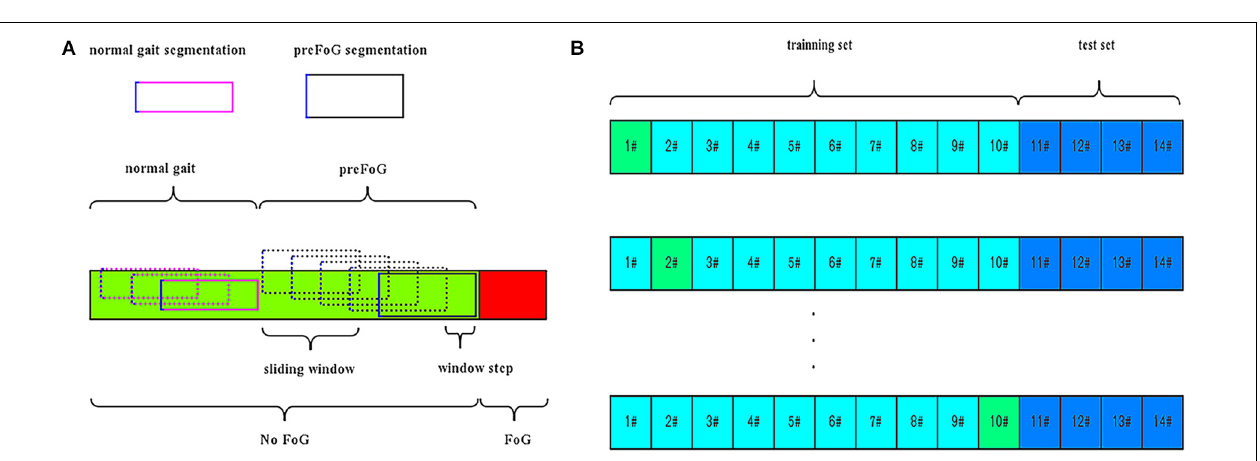
FIGURE 2 | The event sequence of a video labeled with FOG, preFOG, and normal segments.